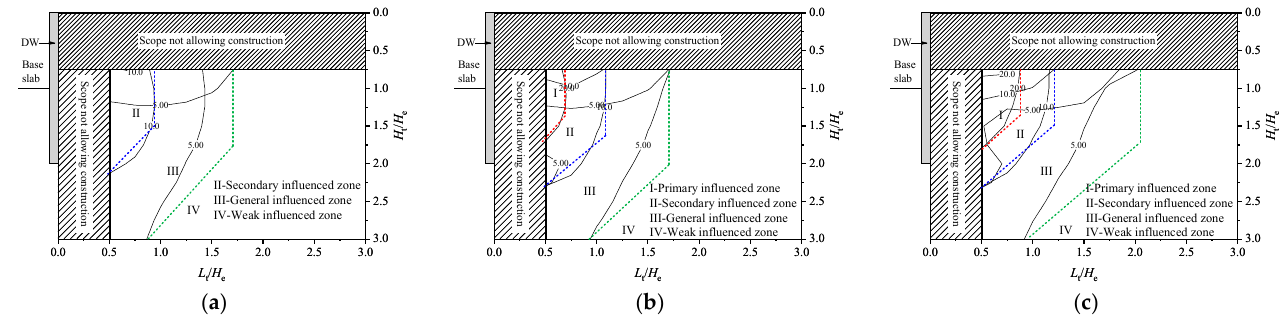
Figure 7. In fl uenced zone of deep excavation on adjacent tunnel displacement ( H e = 12 m): ( a ) δ hm = Figure 7. Influenced zone of deep excavation on adjacent tunnel displacement ( H